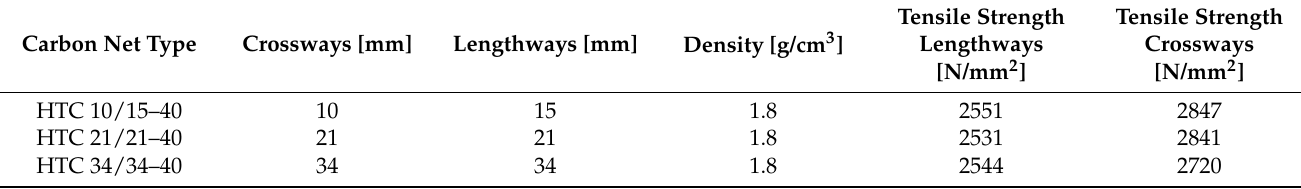
Table 2. Physical characteristics of the carbon nets.